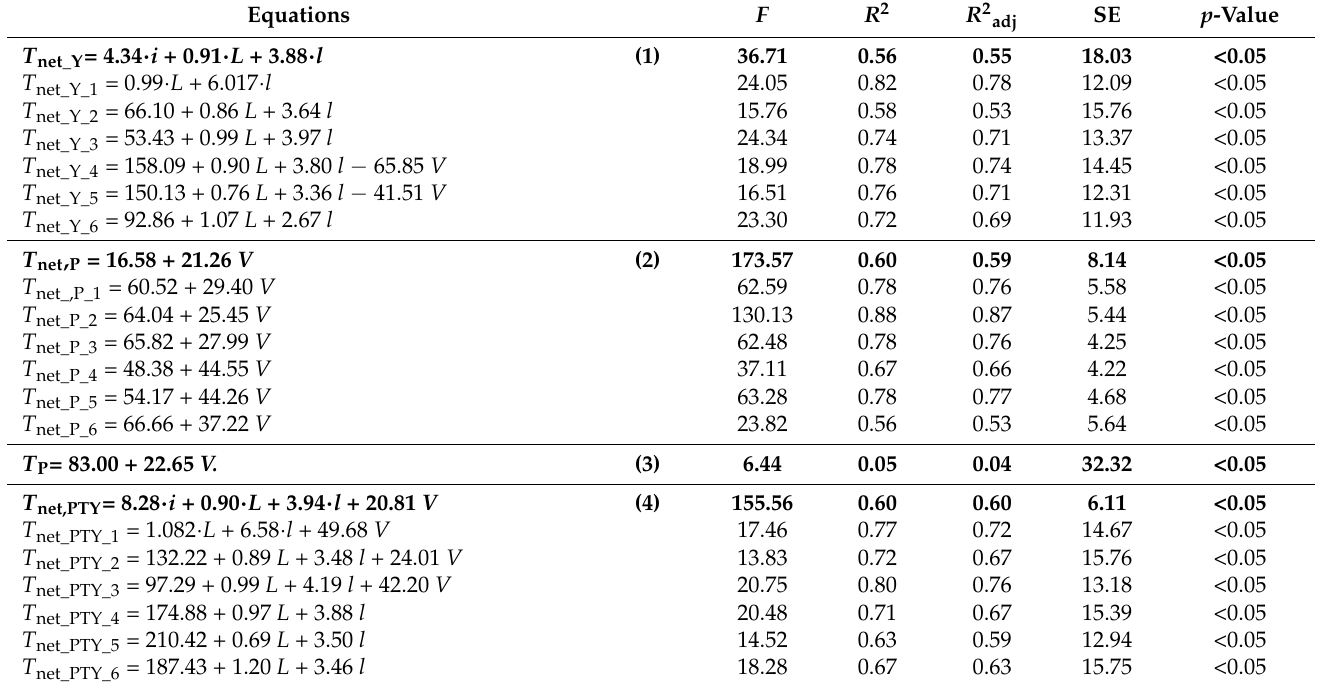
Table 4. Summary of the work cycle time models ( T net ).